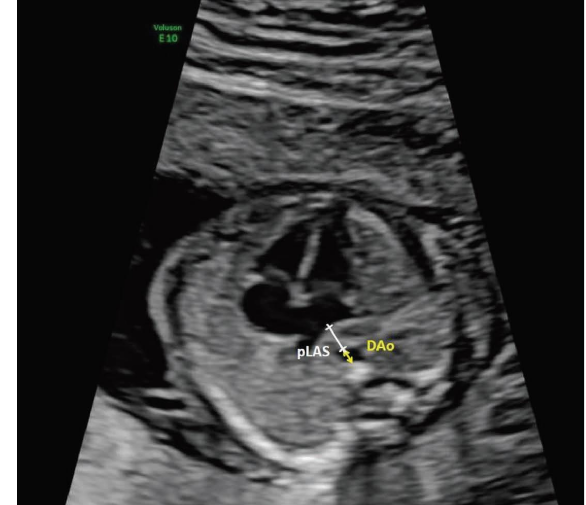
Figure 4: Standard 2D greyscale ultrasound image of the 4- chamber view of the fetal heart with callipers (white) measuring the post-LA space (pLAS) and yellow callipers measuring the di- ameter of the descending aorta (DAo). (legend: pLAS � postleft atrial space, and DAo � descending